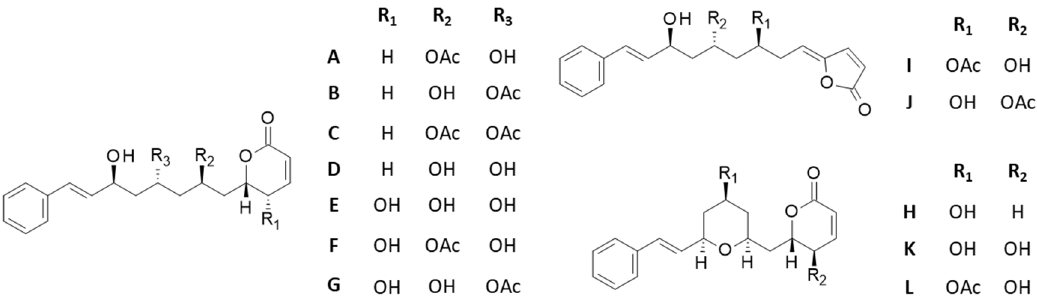
Figure 2. Structures of cryptoconcatones A-L isolated from the leaves and twigs of the tree Cryptocarya concinna Hance (Lauraceae).